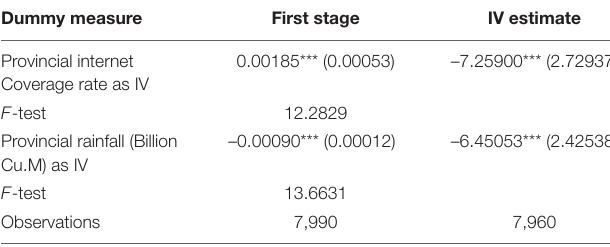
TABLE 3 | The effect of Internet utilization on subjective social justice. TABLE 4 | Instrumental variable approach